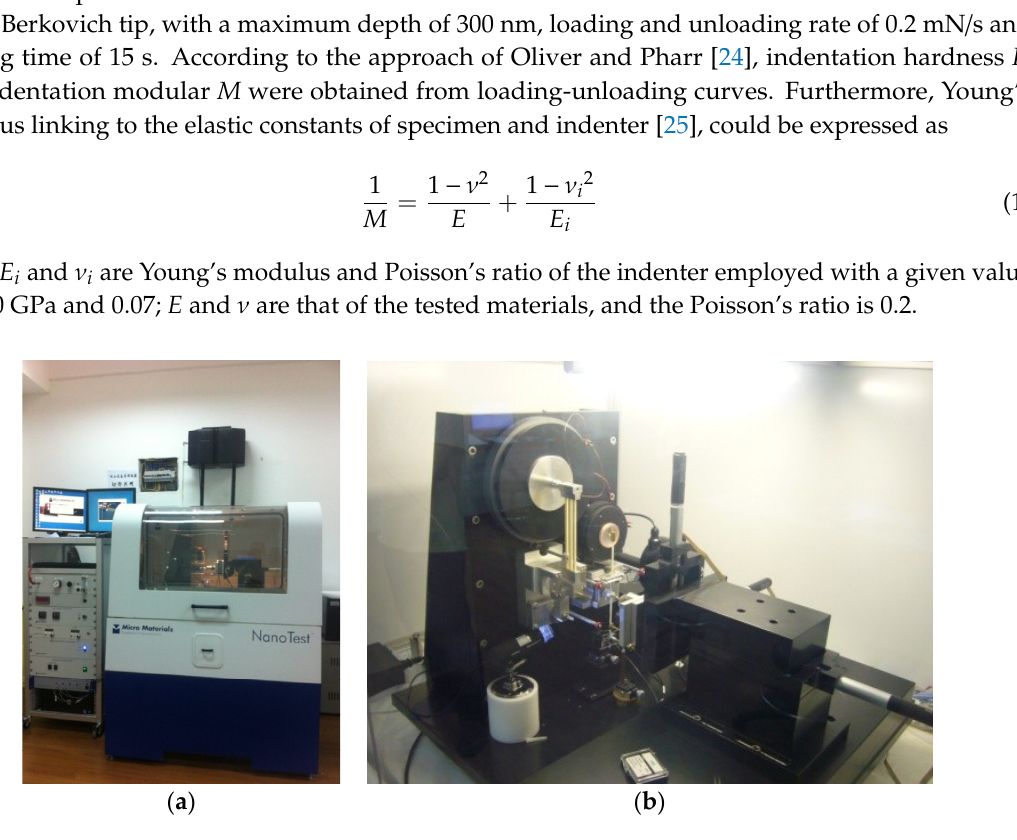
Figure 2. NanoTest Vantage testing system: ( a ) appearance; and ( b ) internal details.